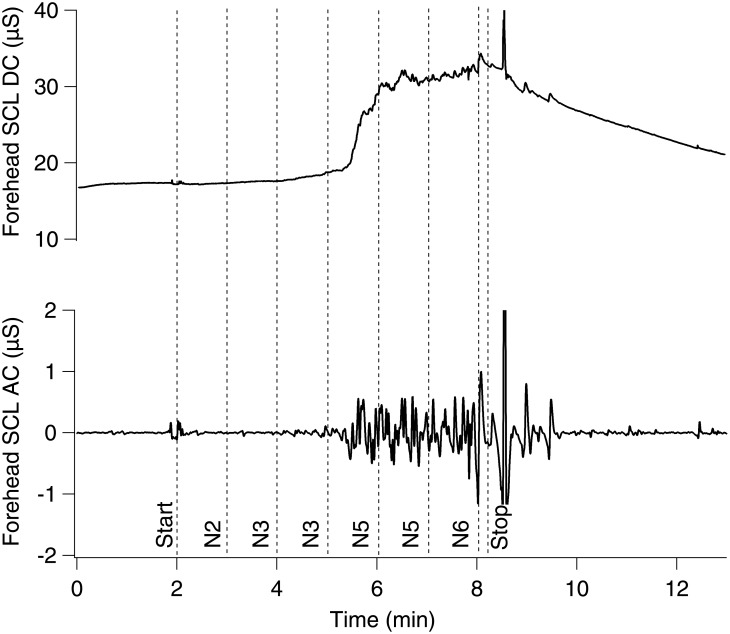
Example of forehead skin conductance recordings obtained in one subject during simulated ride.Top trace—tonic SCL; bottom trace—phasic SCL. Vertical lines depict start/stop of the virtual ride and nausea ratings; prior to the ride onset nausea rating was zero.